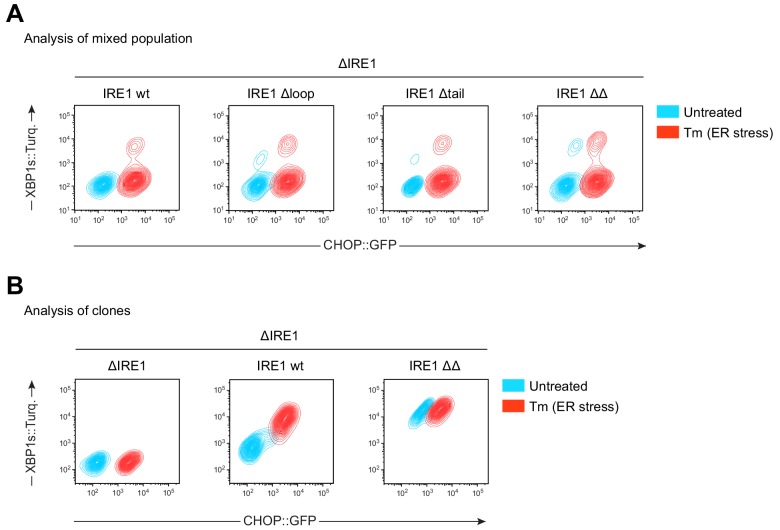
Single or double deletion of a flexible loop and the tail within IRE1LD de-repressed IRE1 basal activity.(A) Two dimensional contour plots of untreated and tunicamycin (Tm)-treated CHO-K1 CHOP::GFP and XBP1s::Turquoise dual UPR reporter cells expressing the indicated alleles (as in Figure 4A) analysed by flow cytometry. The measurements were performed after transient transfection of Cas9-CRISPR guides together with the respective repair templates yielding populations that had and had not undergone homologous recombination (‘Analysis of mixed population’). Representative data from four independent experiments is shown. (B) Contour plot (as in ‘A’) of clonal cell lines expressing the same alleles used in the experiment shown in Figure 4B. Representative data from three biological repeats is shown.